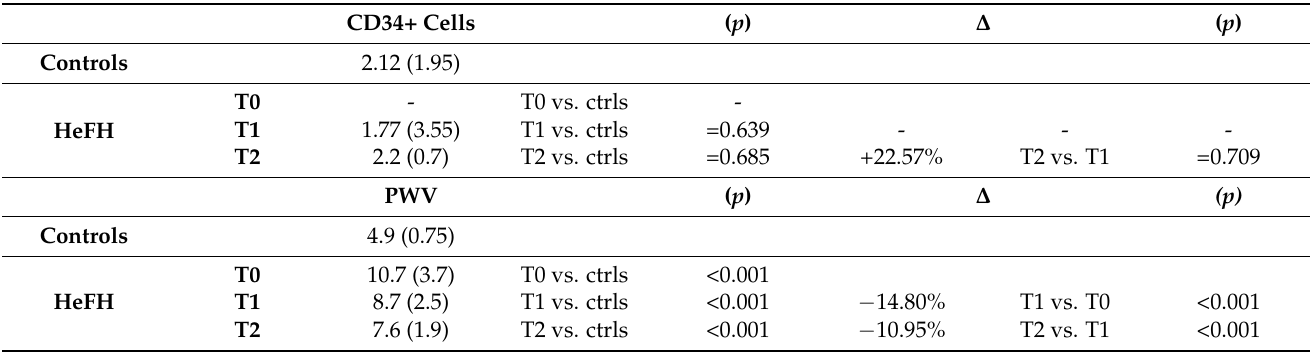
Table 3. Analysis of change in CD34+ cell number and PWV over time points in HeFH